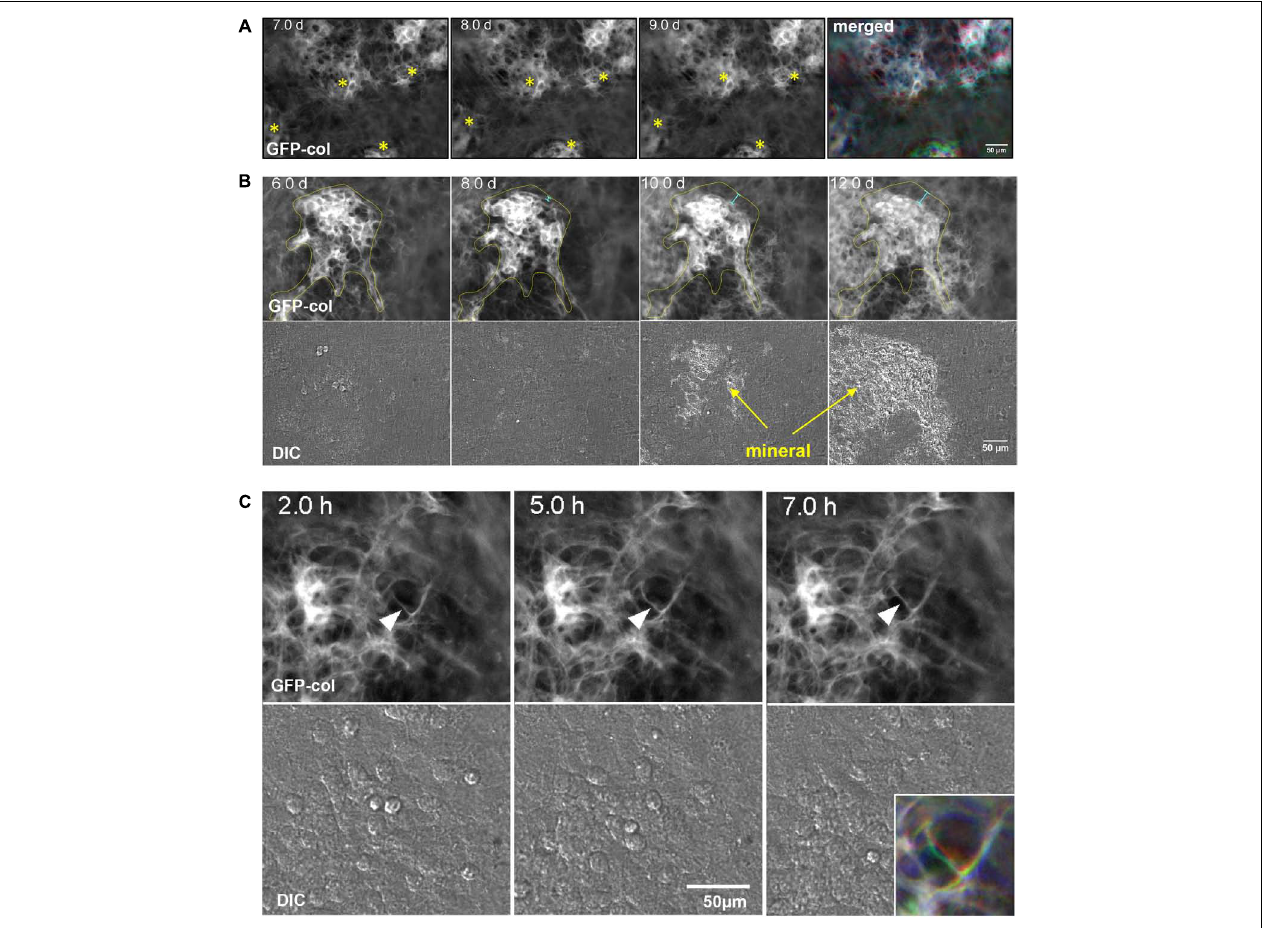
FIGURE 3 | Dynamic events during collagen assembly. (A) Still frames from timelapse imaging of bone nodules forming in long-term osteogenic calvarial cell cultures. Note the nodules marked with the asterisks that move relative to each other. This is best appreciated by viewing Supplementary Movie 5 . The RGB color image on the right shows the 7, 8, and 9 day images merged into the red, green, and blue channels respectively. (B) Still frames from timelapse imaging of a bone nodule mineralizing. The collagen in the osteogenic nodule is outlined in yellow at day 6 and the same outline is superimposed on the images at days 8, 10, and 12. The light blue distance bars indicate compaction of the collagen relative to the original contours of the nodule. This is best appreciated by viewing Supplementary Movie 7 . (C) Still frames from a timelapse movie illustrating local motions of an individual fibril marked with an arrowhead. The fibril starts out straight at 2 h and is deformed by local cell motion at 5 h before becoming straightened again at 7 h. These local fibril dynamics are best appreciated by viewing Supplementary Movie 8 , where you can see this and other fibrils repeatedly being stretched and distorted by local cell motions. The colored inset image in the lower right shows the same fibril from the 2, 5, and 7 h images merged into the red, green, or blue channels respectively. In all panels, bar = 50 µ